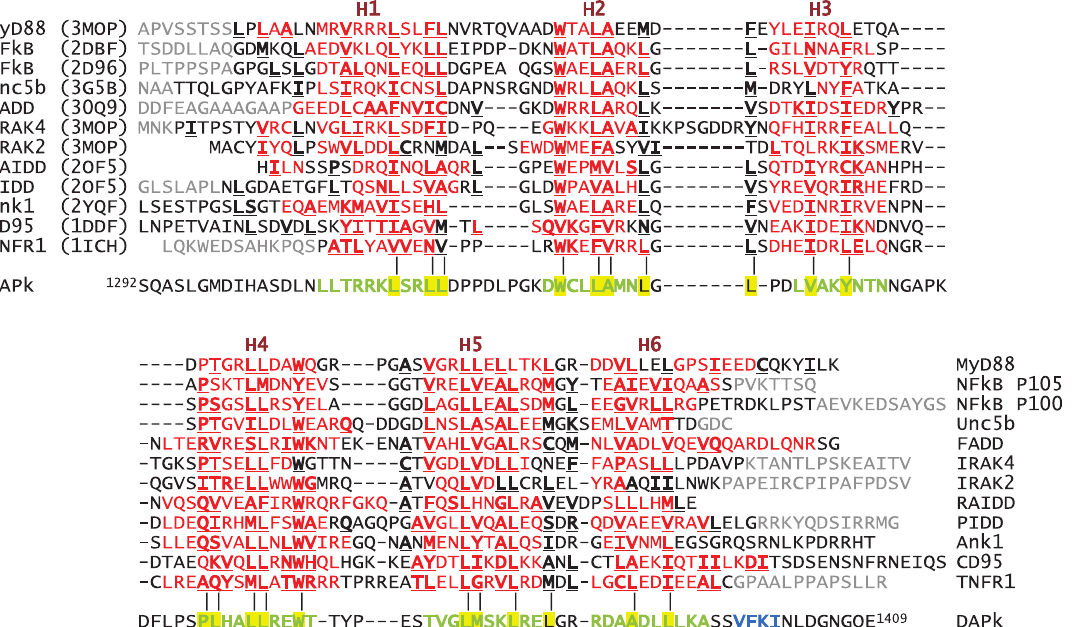
Figure 1. Sequence alignment DAPk-DD against death domains with known 3D structures. Residues assigned in helical secondary structures H1 through H6 (dark red labels) are shown in red, and those with buried side chains are shown in bold and underlined. Residues present in the native protein but not included or visible in the corresponding structure are shown in grey. The alignment has been manually curated on the basis of a multiple superposition of the 3D coordinates. The sequences are displayed in rank order of sequence identity to DAPk-DD: (top) MyD88 (PDB code 3MOP); NF- k B p105 subunit (2DBF); NF- k B p100 subunit (2D96); Unc5b (3G5B); FADD (30Q9); IRAK4 (3MOP); IRAK2 (3MOP); RAIDD (2OF5); PIDD (2OF5); ankyrin1 (2YQF); CD95/Fas (1DDF); TNF receptor-1 (1ICH). The DAPk-DD region is shown at the bottom; the result of sequence-based secondary structure prediction (JPRED) is indicated as bold green letters for a -helix and bold blue letters for b -strand; yellow backgrounding highlights unambiguous conservation of hydrophobic buried residues compared to the other DD sequences. Note the difficulty to assign such conservation for the putative H6 of DAPk-DD, as well as a uniquely long H3-H4 loop.